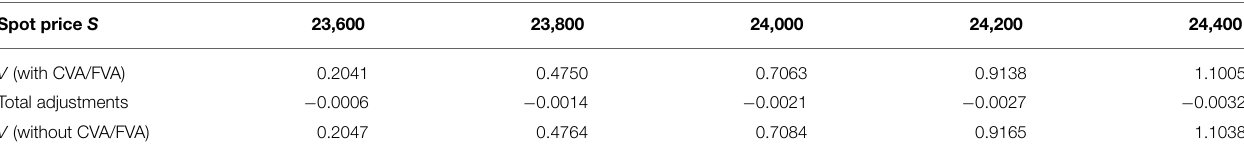
TABLE 11 | Prices of down-and-out put under KoBoL process as of 9 January 2015, time to maturity T = 0 . 463 , spot, strike S = K = 24 , 000 , barrier H = 23 , 500 , risk-free rate r = 0 . 52 % , collateral rate r C = 1 % , funding rate r F = 1 . 7 % default intensity λ = 0 . 05 , recovery rate R B = 0 . 4 , collateral threshold H B = 0 . 1 , CPU time: 16.70s.